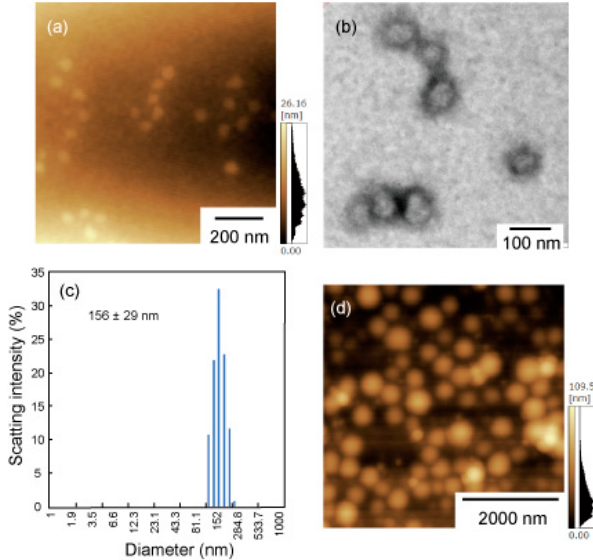
Figure 2. Atomic force microscopy (AFM) ( a , d ) and transmission electron microscopy (TEM) ( b ) images of poly(NAAMe 53 - b -NAGMe 240 - b -NAAMe 53 ) aqueous solutions. Sample preparations were performed by incubation at 35 °C ( a , b ) and 70 °C ( d ) and subsequent staining with phosphoyungstic acid (1.0 wt %) for TEM observation. Size distribution of poly(NAAMe 53 - b -NAGMe 240 - b -NAAMe 53 ) (0.25 wt %) at 35 °C was estimated by means of dynamic light scattering (DLS) measurement ( c ).